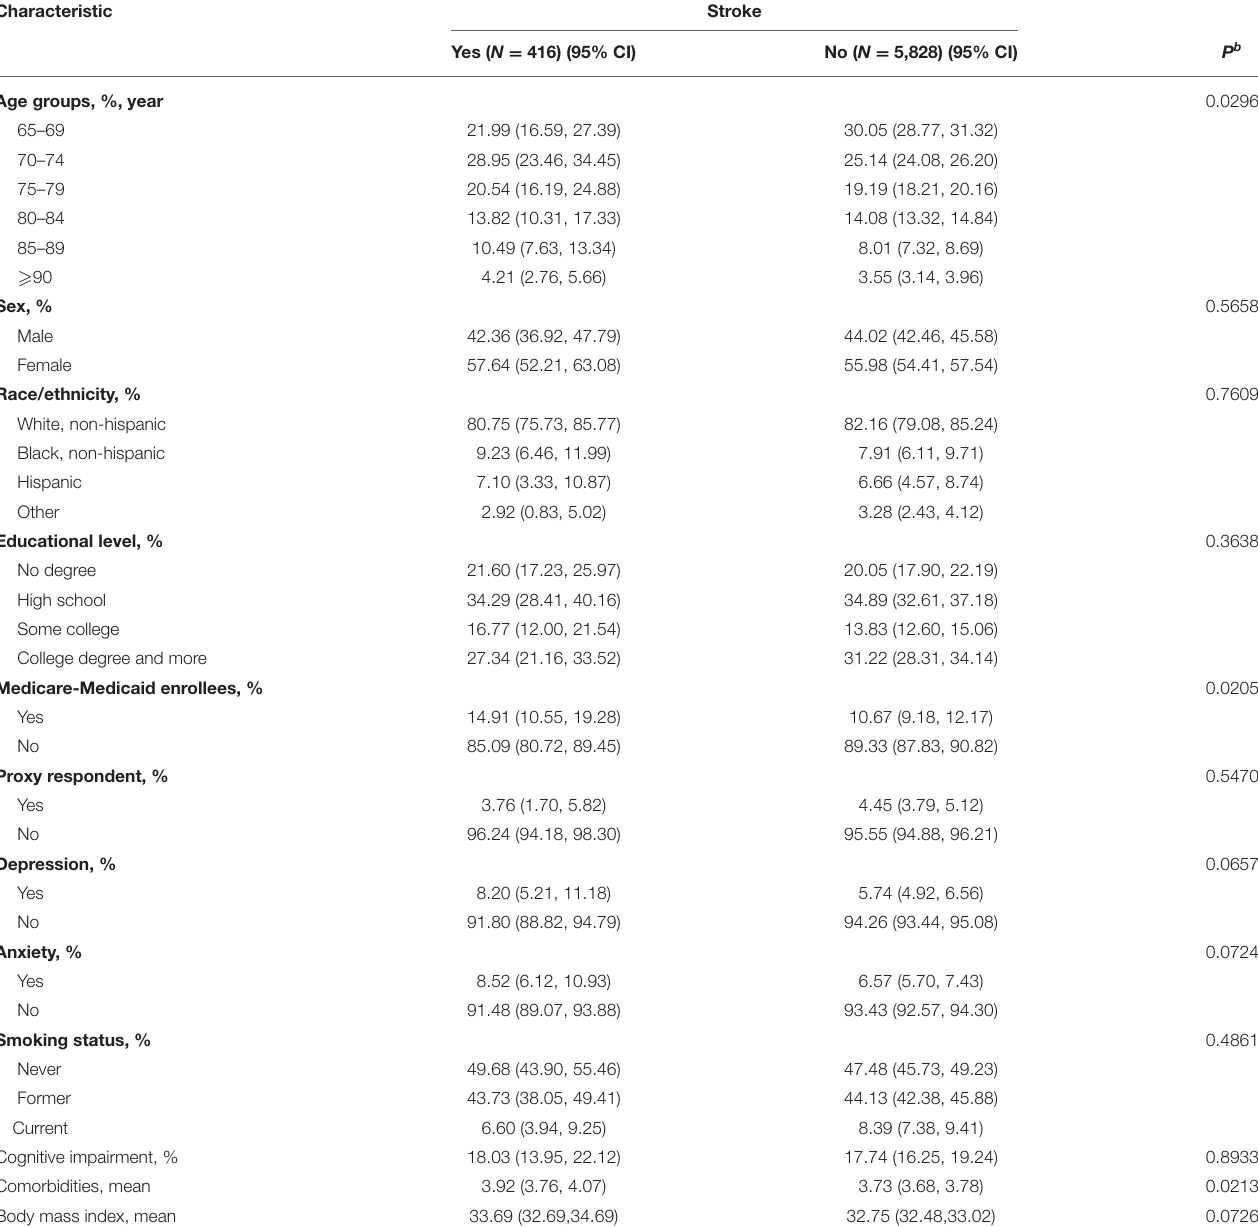
TABLE 2 | Weighted sample characteristics and comparisons stratified by stroke during the 8 years of follow-up a .